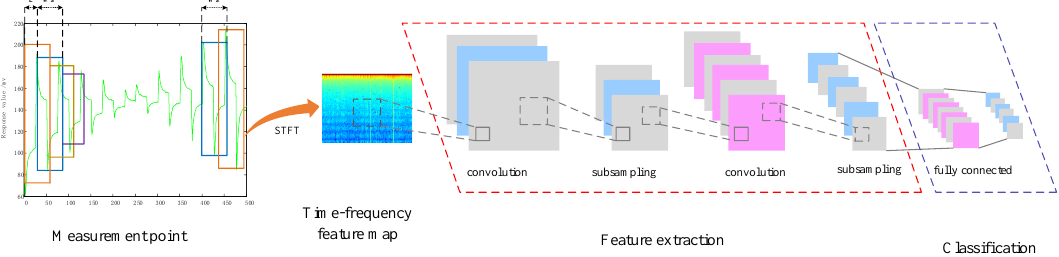
Figure 7. The structure of proposed features extraction method.